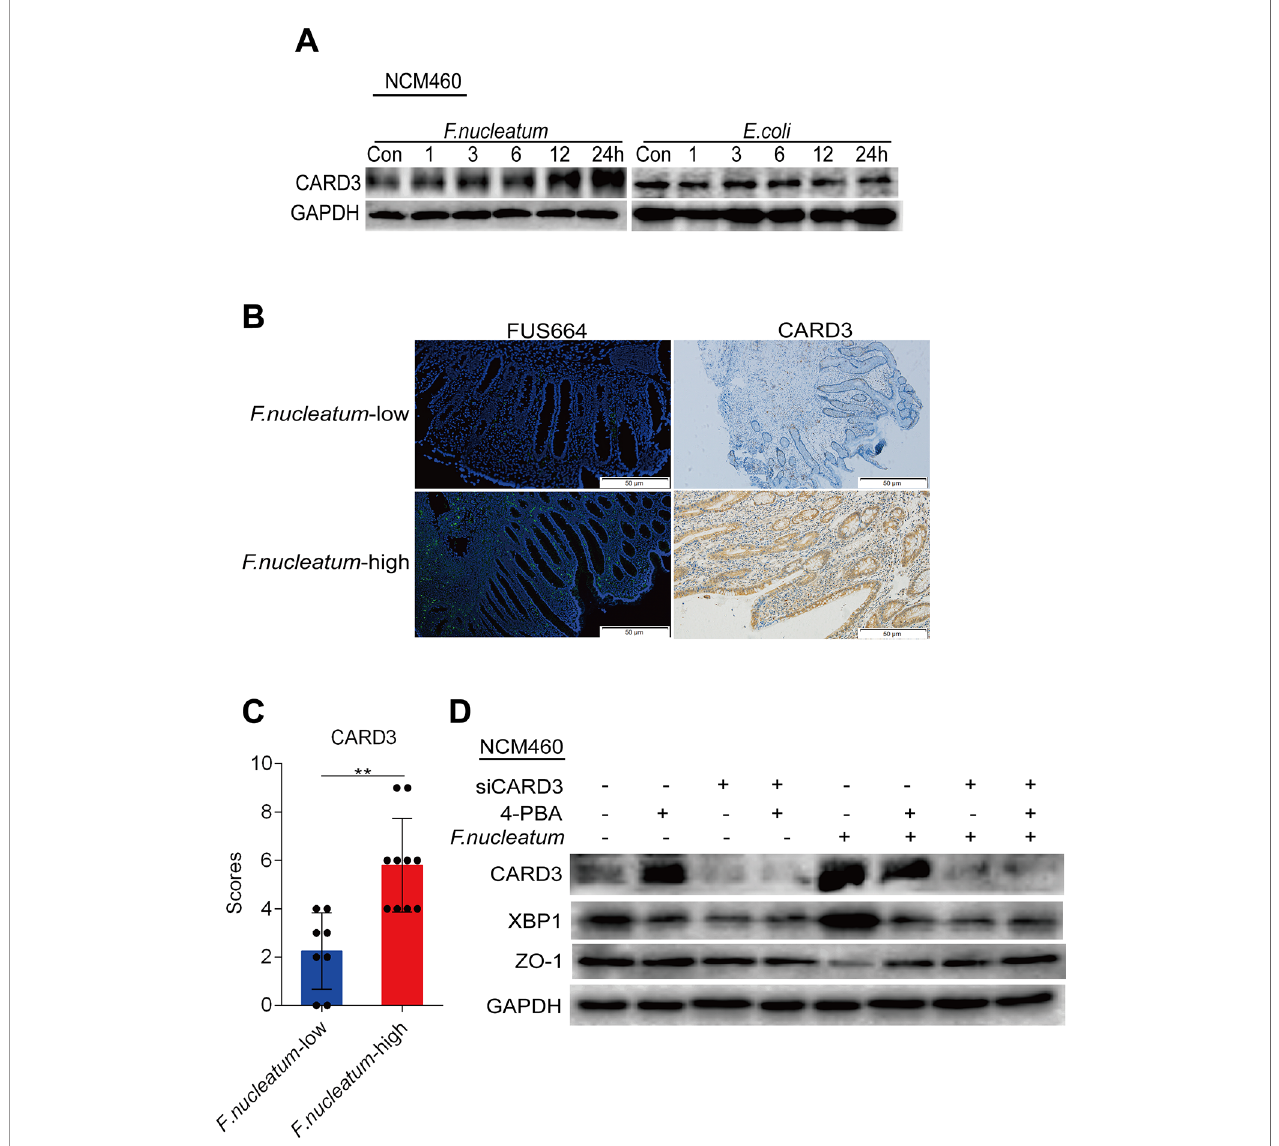
FIGURE 5 | Fusobacterium nucleatum is associated with caspase activation and recruitment domain 3 (CARD3) expression and activates the endoplasmic reticulum (ER) pathway via CARD3 in NCM460 cells. (A) Western blotting was performed to measure CARD3 protein expression over time in NCM460 cells cocultured with F. nucleatum or Escherichia coli over time. (B, C) Representative images showing that the abundance of invasive F. nucleatum in CD tissues is associated with high expression of CARD3 (** P < 0.01; unpaired Student ’ s t test; the error bars indicate the SDs; 200× magni fi cation). (D) Western blotting was performed to measure the protein levels of CARD3, XBP1, and ZO-1 in NCM460 cells transfected with nontargeting siRNAs (NC), 4-phenyl butyric acid (4-PBA), or siCARD3 and infected with F.